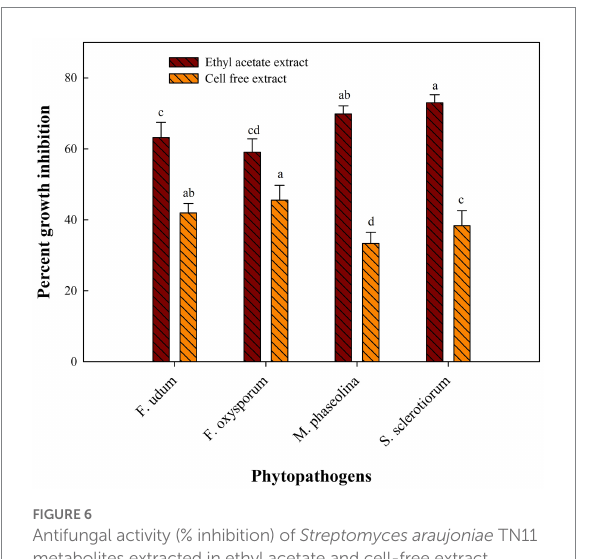
FIGURE 7 Antifungal activity (% inhibition) of Streptomyces araujoniae TN19 metabolites extracted in ethyl acetate and cell-free extract against different fungal pathogens. The data are the mean of three replicates ± standard error, within each graph, values followed by the same letter are not significantly different ( p ≤ 0.05) according to Duncan’s multiple range test.